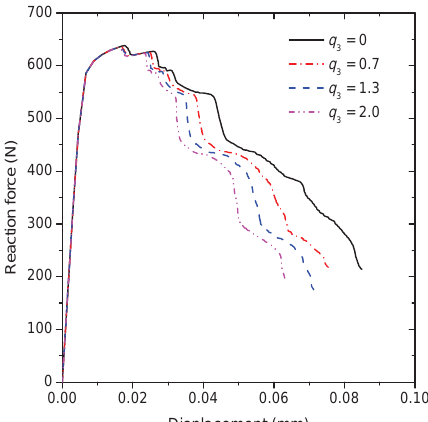
Figure 10. Computational results of the reaction force versus the applied displacement curves for different values of q 3 .